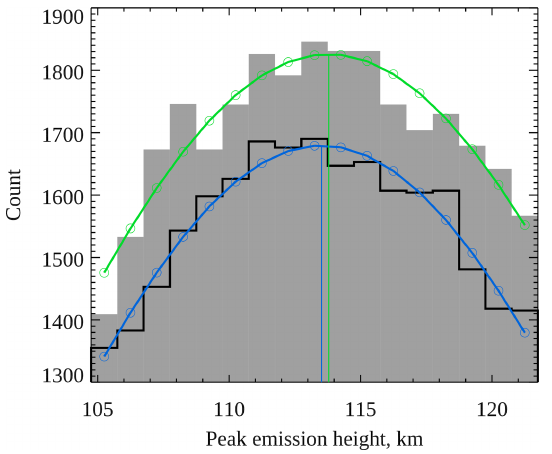
Figure 2. The peaks of the histograms as shown in Fig. 1, together with Gaussian curves fitted to the histograms for the 557.7nm emis- sion (green) and 427.8nm emission (blue). The vertical green and blue lines mark the peaks of the